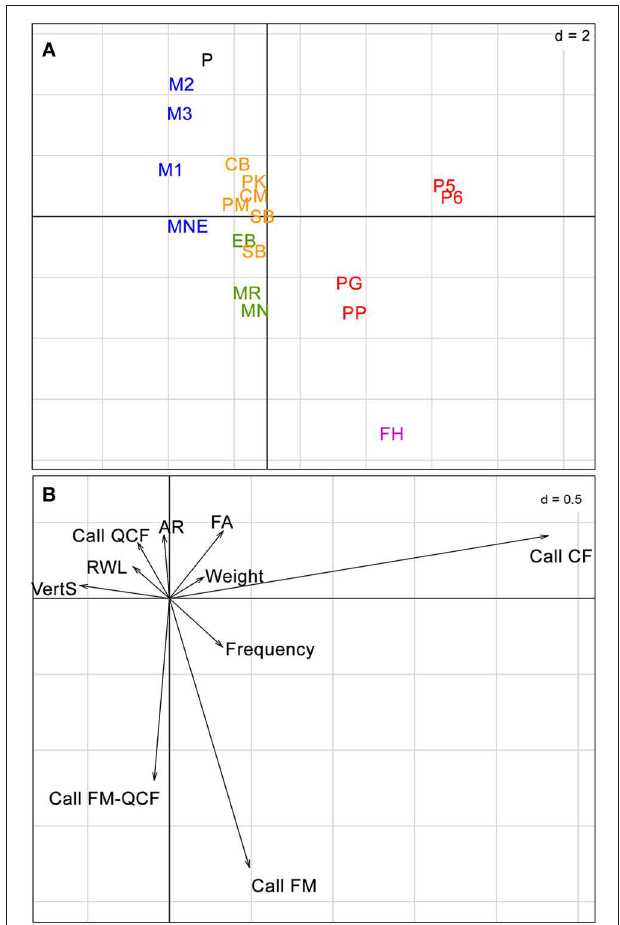
FIGURE 3 | Biplots from the Hill-Smith PCA of the functional traits (Q table). (A) Species. Red, Mormoopidae; Pink, Furipteridae; Green, Vespertilionidae; Orange, Emballonuridae; Blue, Molossidae (see Table S1 for species abbreviations). (B) Traits (see Table 1 for trait